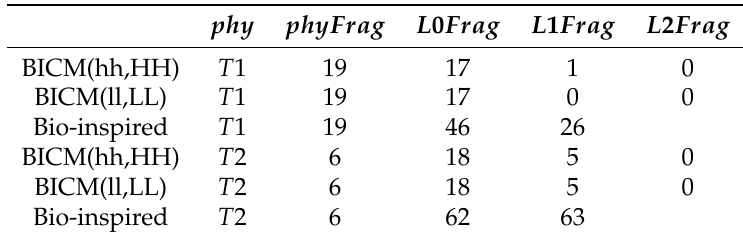
Table 4. Number of trials in which the virtual or physical topology fragments when nodes are removed by random failure.